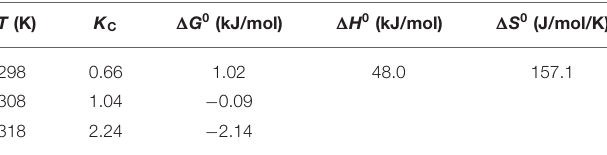
TABLE 4 | Thermodynamic parameters for the adsorption of TC on BC800 at different temperatures. T (K) K